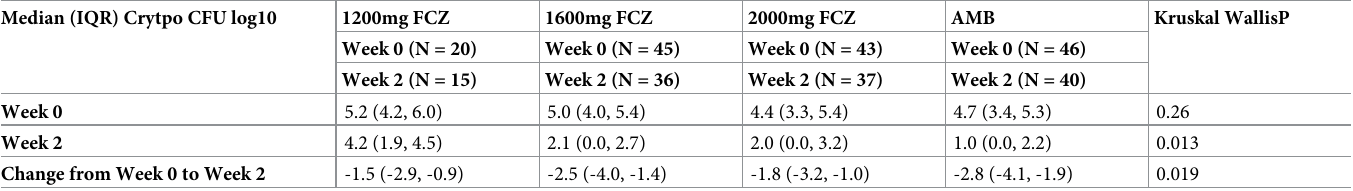
All p-values are calculated using the Kruskal-Wallis test for differences across the four treatment arms.